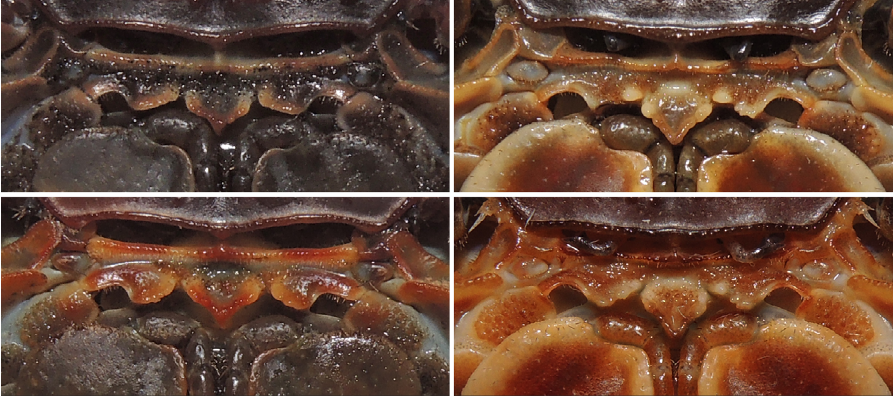
Figure 9. Detail of frontal region of Epilobocera capolongoi (upper left: CZACC 5.0047; lower left: CZACC 5.0045) and E. cubensis (upper right: CZACC 5.0050; lower right: CZACC 5.0051), showing variation in the shape of the epistome and the branchial efferent channel